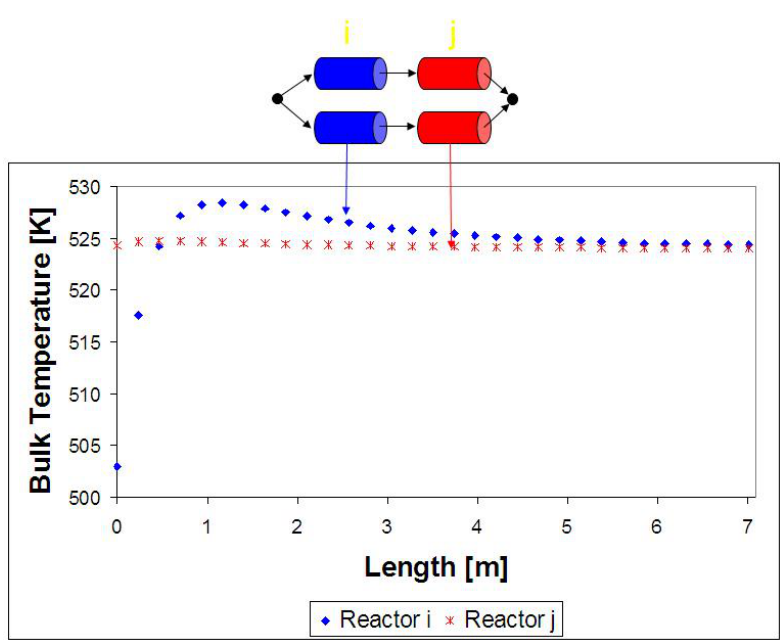
Figure 7 . Temperature profiles for optimal structures of methanol reactors at